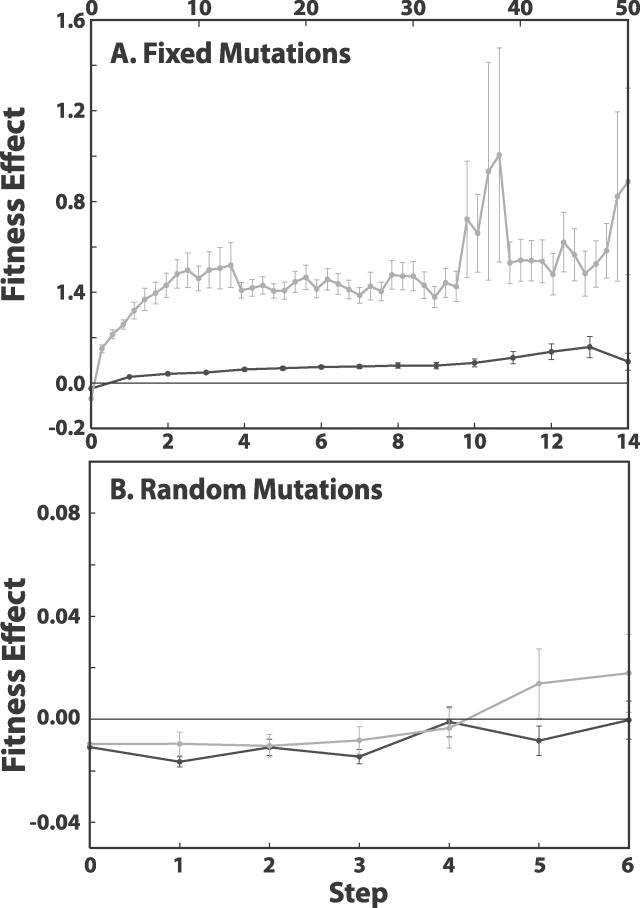
Fixed Deleterious Mutations Interact Positively with Subsequent Substitutions, while Random Deleterious Mutations Generally Remain Deleterious(A) Mutations that were initially deleterious and ultimately fixed tended to become beneficial before their fixation. It is apparent that the largest increases in fitness occurred in the first few subsequent mutations.(B) In contrast, random deleterious mutations generally remained deleterious with subsequent mutations. In both graphs, the black lines correspond to U = 0.08 and the light lines to U = 0.32 (error bars represent one standard error of the mean). The horizontal lines separate the beneficial (above) and deleterious (below) fitness effects. The fitness effect of a mutation is calculated as
, where
is the fitness effect of the descendent lineage without the fixed mutation and
is the fitness effect of the descendent lineage with the fixed lineage.